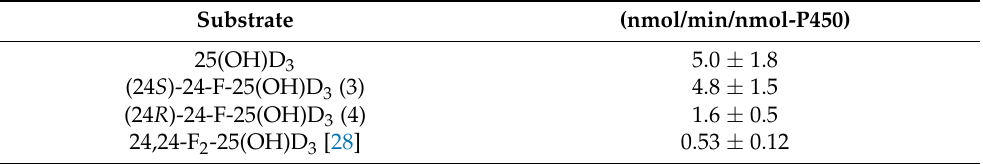
Table 2. Hydroxylation activities of human CYP24A1 toward 25(OH)D 3 and its C24-fluorinated